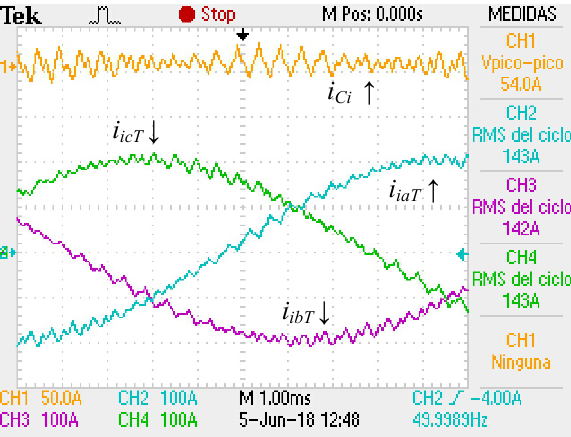
Figure 20. Input currents between LCL filter VSC i .